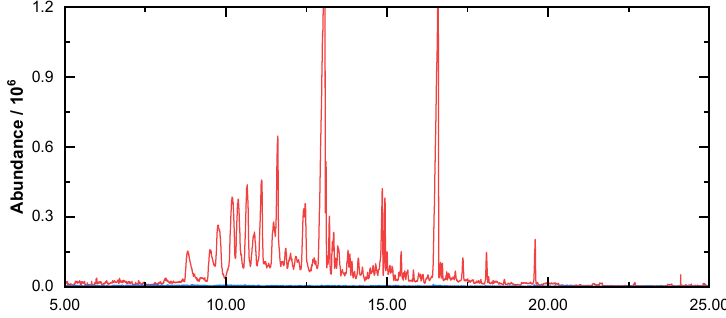
Figure 2. GCMS chromatogram of VOCs and sVOCs present in the commercial PE stock (red) and the absence of these compounds after 50 h of heating at 70 °C (blue).